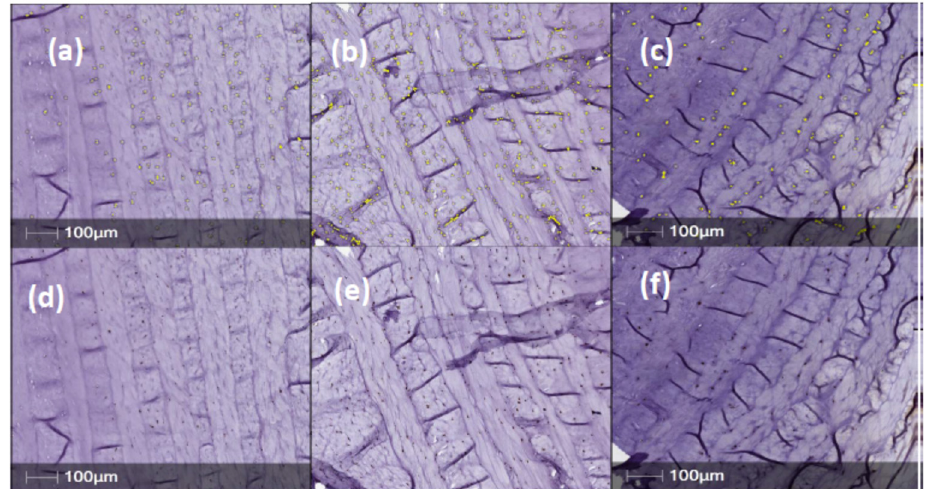
Figure 5. Representative samples for CALCRL immunostaining of canine IVDs in normal, PBS (n = 10) and NTG-101 (n = 12) injected IVDs. ( a – c ) Top panels show immunopositive cells with yellow overlay from HALO automated cell counting with bottom panels. ( d – f ) showing DAB chromogen immunostained cells.